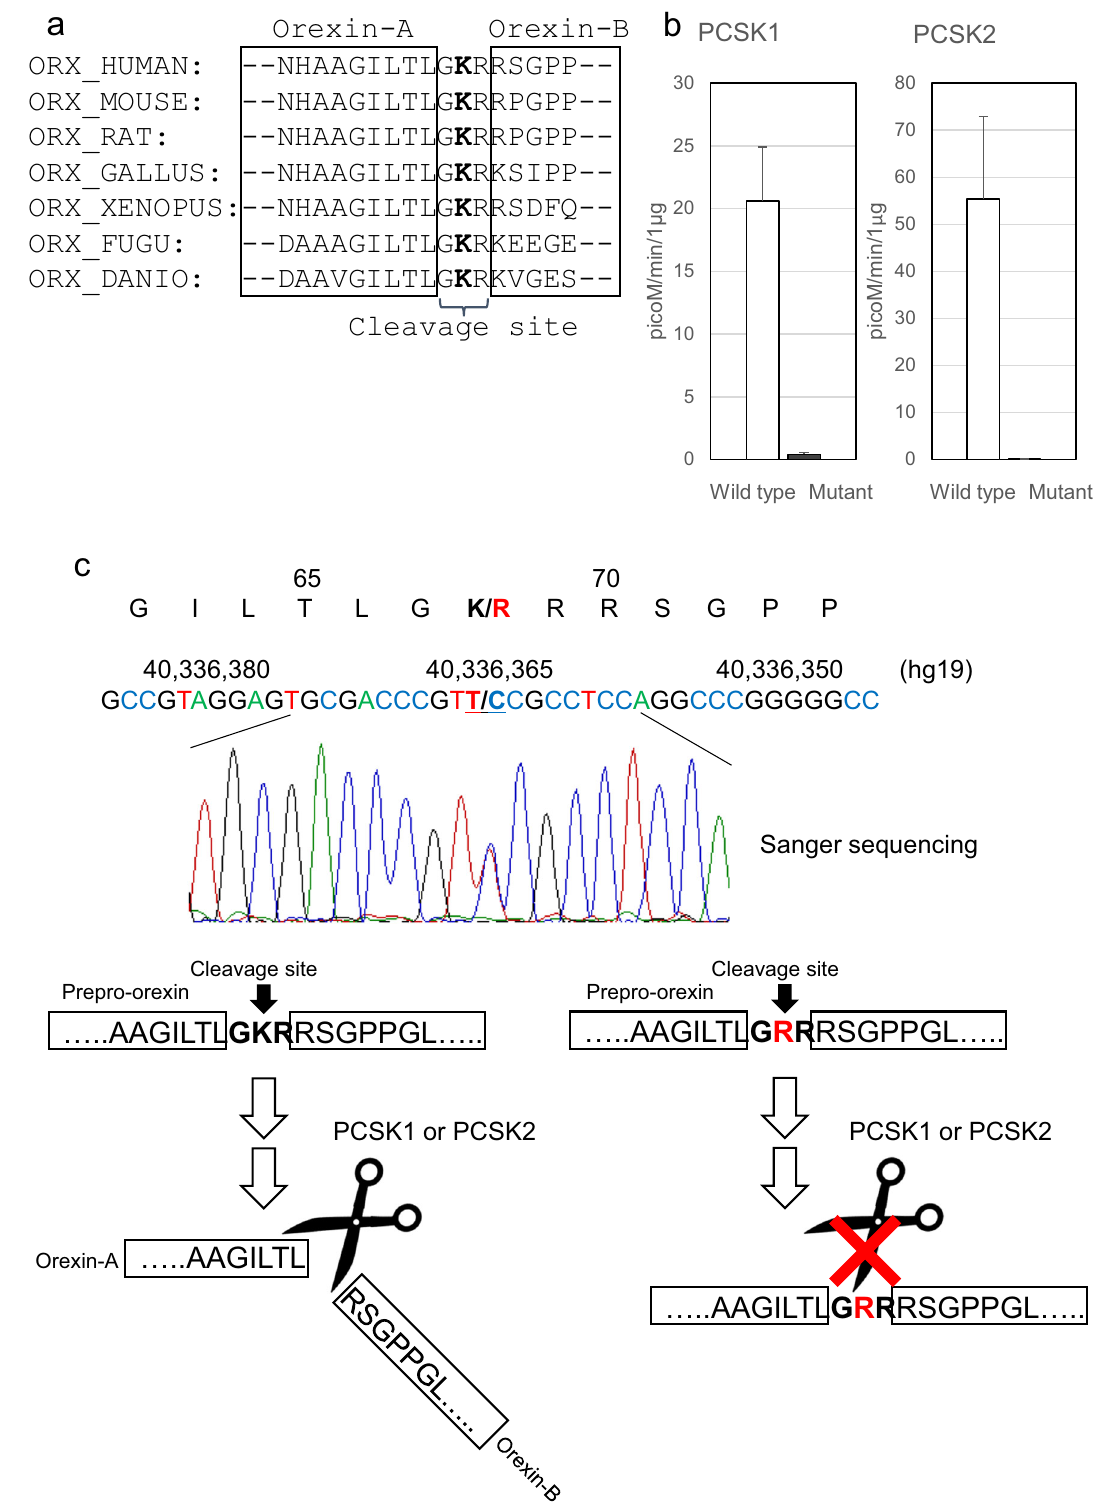
Fig. 1 PCSK1 and PCSK2 enzyme activity against prepro-orexin peptides. a Alignment of part of the prepro-orexin (ORX) sequence from human ( Homo sapiens ), mouse ( Mus musculus ), rat ( Rattus norvegicus ), chicken ( Gallus gallus ), frog ( Xenopus laevis ), puffer fi sh ( Takifugu rubripes ), and zebra fi sh ( Danio rerio ). b Two peptides, wild-type orexin fragment (Wild type) and mutant orexin fragment (Mutant), were prepared for the enzyme activity analysis. All values are the mean ± standard deviation. c The p.Lys68Arg amino acid substitution was predicted to change the ef fi ciency of prepro-orexin cleavage, which is catalyzed by PCSK1 or PCSK2.